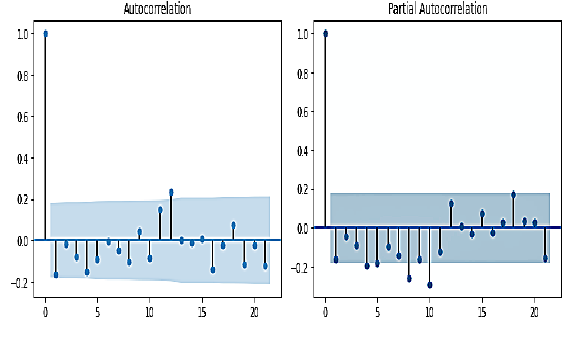
Figure 6. ACF and PCF plots.